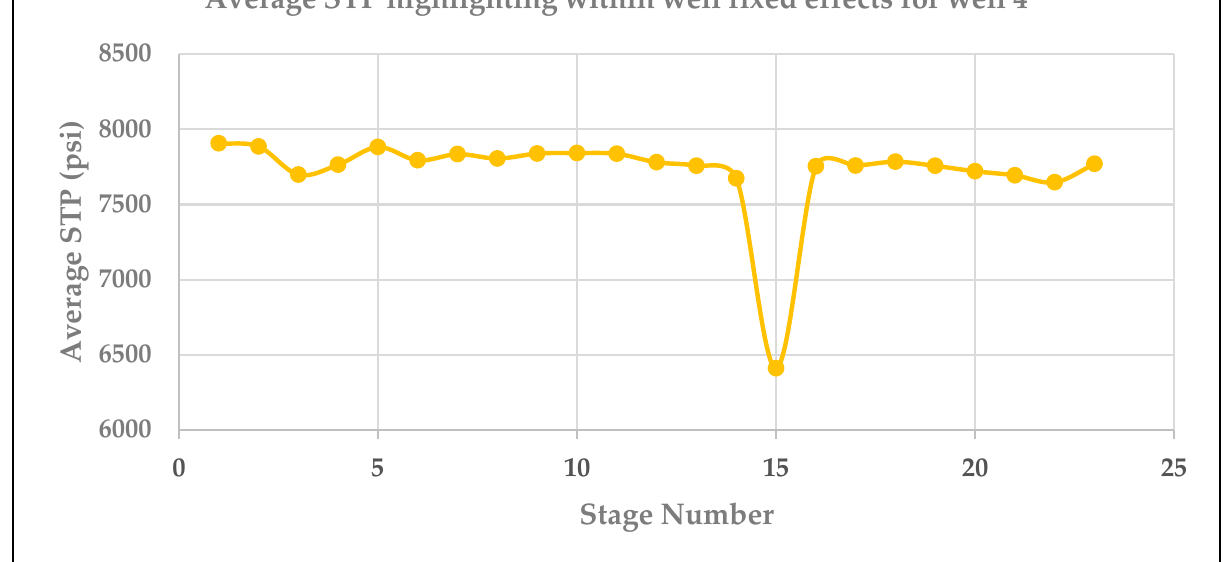
Figure 7. Plot showing trend in average STP for well 4.